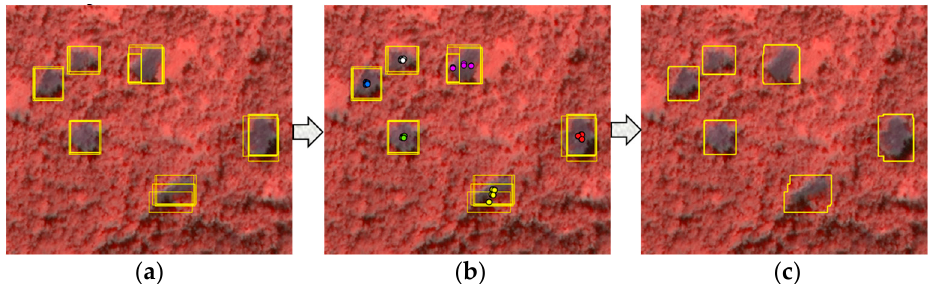
Figure 7. Post-processing steps: ( a ) Ori-results polygons, ( b ) density-based clustering for center coordinate points, different colors represent different clustering classes, ( c ) final result after merging the same clustering.